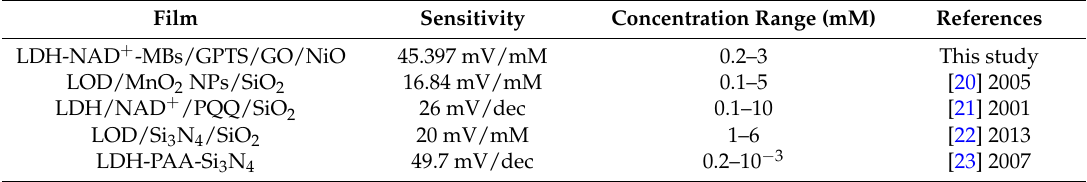
Table 3. The comparisons of sensitivity and linearity for lactate biosensors with various